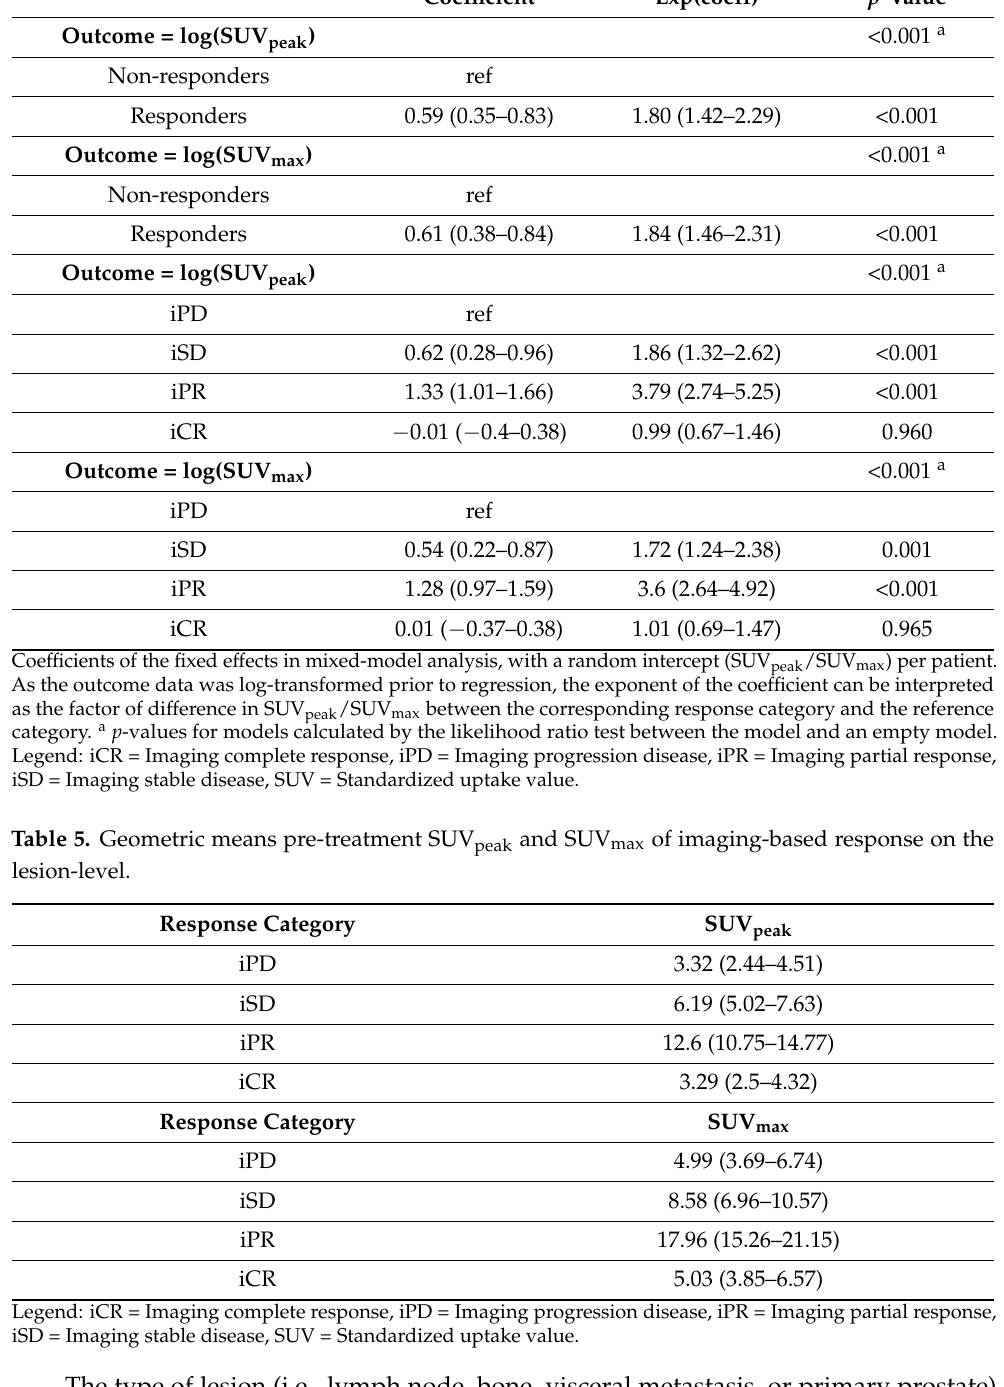
Table 4. Mixed model of imaging-based response on the lesion-level. Coefficient Exp(coeff) p -Value Outcome = log(SUV peak ) <0.001 a Non-responders